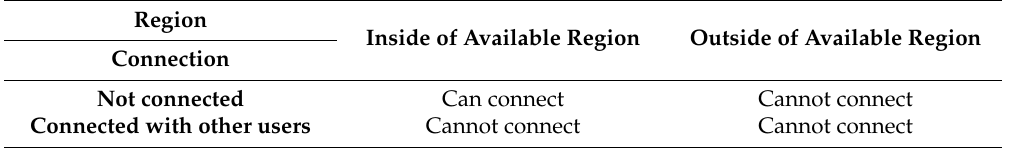
Table 1. Criterion for a waiting robot to decide whether to Table 1 . Criterion for a waiting robot to decide whether to join.